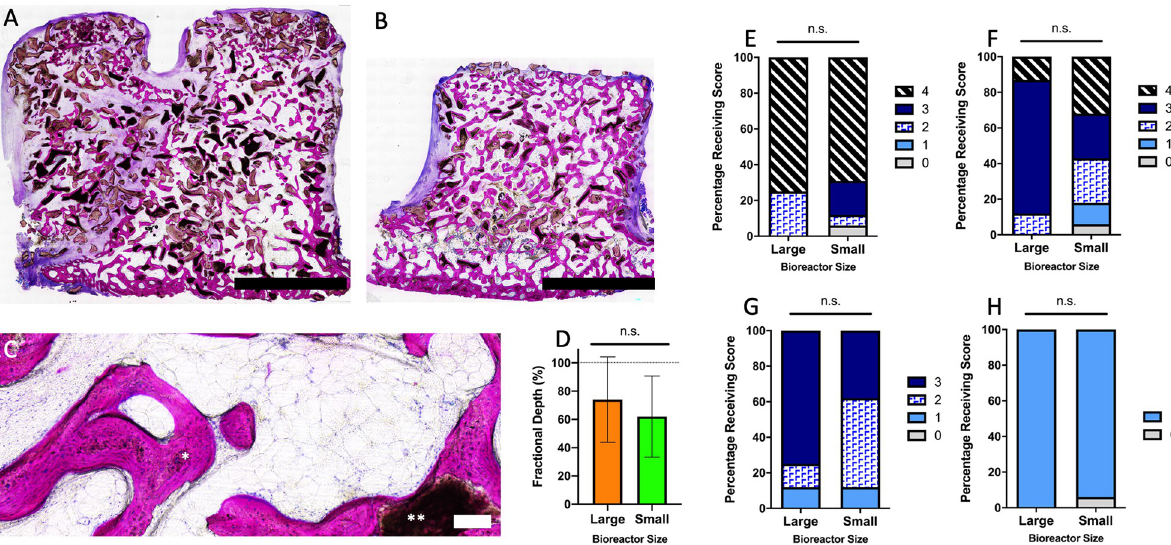
Fig 7. Histological analysis of bioreactor tissues. Low magnification images are shown of tissue in the large (A) and small (B) bioreactors. A high magnification image (C) shows bone forming around autograft and xenograft within the bioreactors. Using these images, the fractional depth (D) was measured, and a blinded panel of histological reviewers were used to determine the autograft coverage (E), xenograft coverage (F), tissue maturity (G), and osteoclast presence (H). Scoring was based on n = 4 large bioreactors and n = 8 small bioreactors. Scale bars: A & B = 5 mm, C = 100 μ m. � = remodeling autograft; �� = xenograft in C. n.s. = non-significant (p > 0.05).